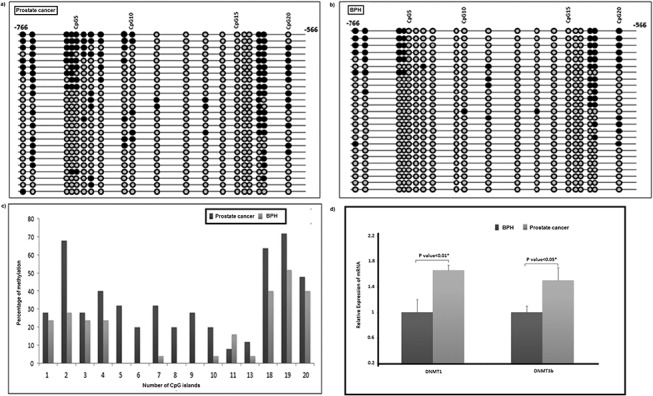
Bisulfite sequencing of hMLH1 promoter at tissue level.(a) and (b) A ball and stick model showing differential methylation of 20 CpG sites in hMLH1 promoter region spanning 200 bp (-766 to -566) under study in prostate cancer and BPH tissues. The grey balls represent unmethylated CpG and black balls represent methylated CpG in the string of DNA sequence. (c) Bar diagram comparing the proportion of methylation of 15 differentially modified CpGs in 50 tissues (prostate cancer: n = 25) and (BPH: n = 25). (d) Bar diagram showing elevated expression of DNMT1 and DNMT3b genes in prostate cancer compared to BPH patients at mRNA level. * indicates P <0.05.